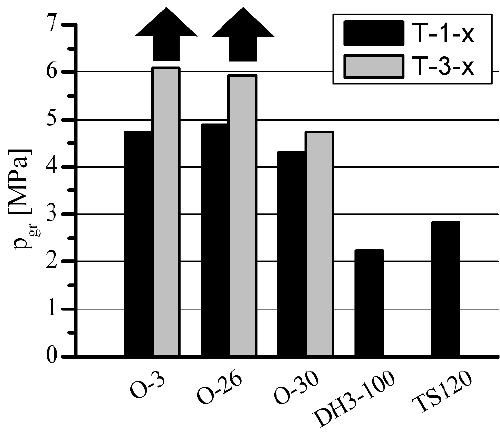
Figure 7. The influence of h-BN on the load capacity of porous sleeves at n = 600 rpm.